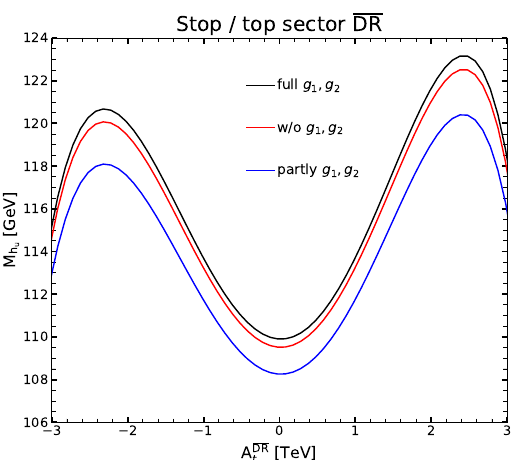
Figure 12 . The mass of the h u -like Higgs boson at two-loop O ( (cid:11) t (cid:11) s + (cid:11) 2 in the top/stop sector for full (black) non (red) or partial (blue) inclusion of the g 1 ; g 2 contributions in the computation of the running DR top mass from the OS input mass (see text for explanation), as a function of A DR t